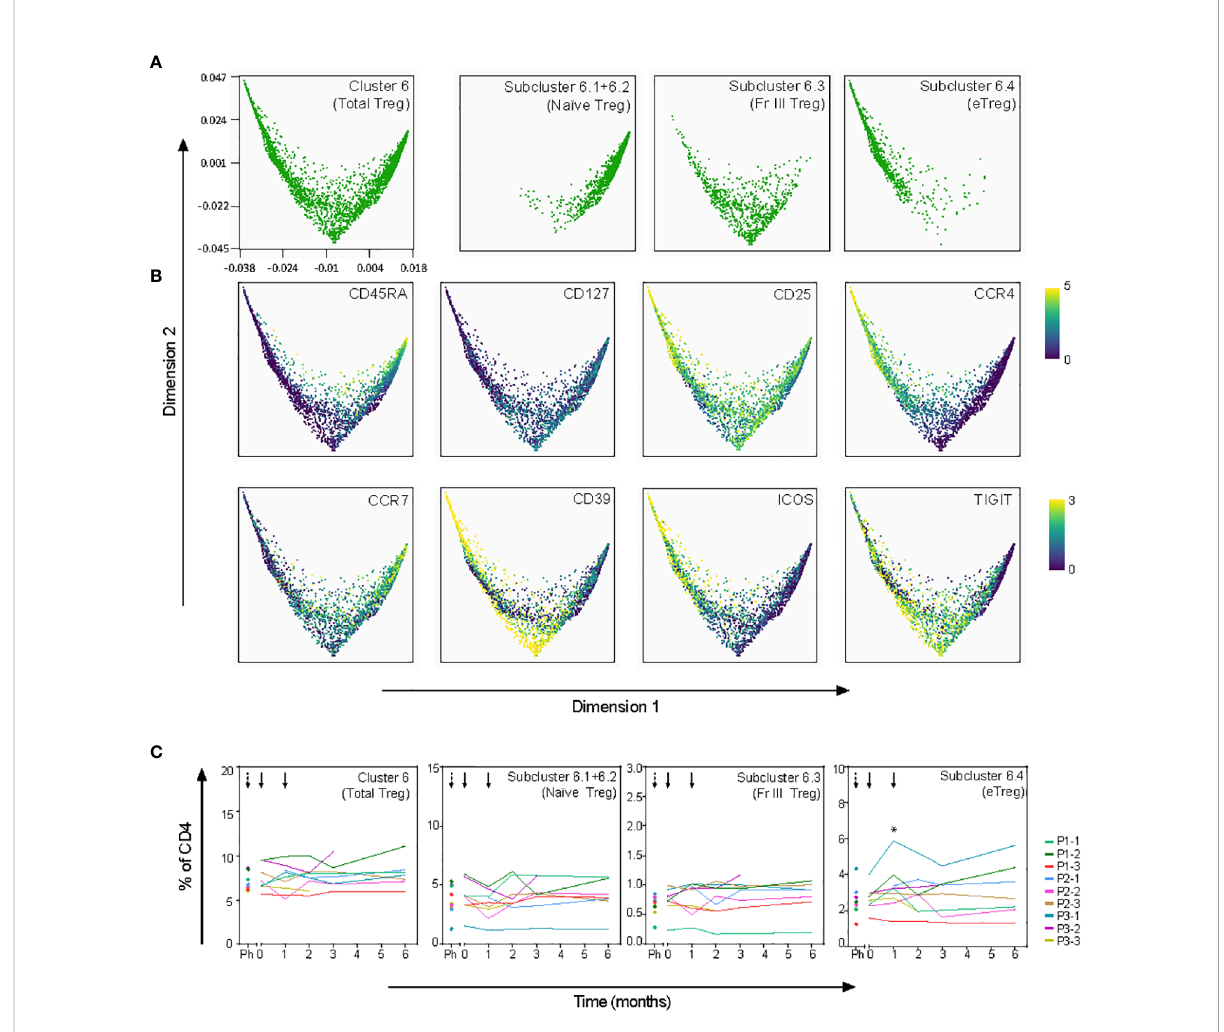
FIGURE 6 Effect of tolDC on regulatory T-cell subsets. Pseudotime analysis (diffusion map) shows differentiation trajectory within Treg cluster 6. (A) Treg subclusters as de fi ned in Cytosplore (Figure 5E) are visualized in the diffusion map. Subclusters 6.1 and 6.2 are plotted together since both subclusters show a naïve phenotype. (B) Speci fi ed markers within the diffusion map. (C) Frequency in time of total Treg and Treg subclusters, shows signi fi cant increase of eTregs (subcluster 6.4) 1 month after tolDC treatment